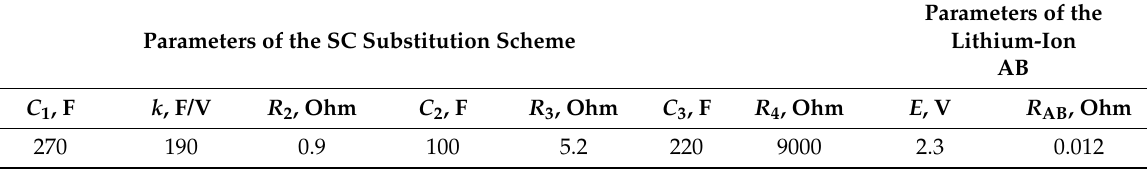
Table 2. Parameters of the SC and lithium-ion battery.